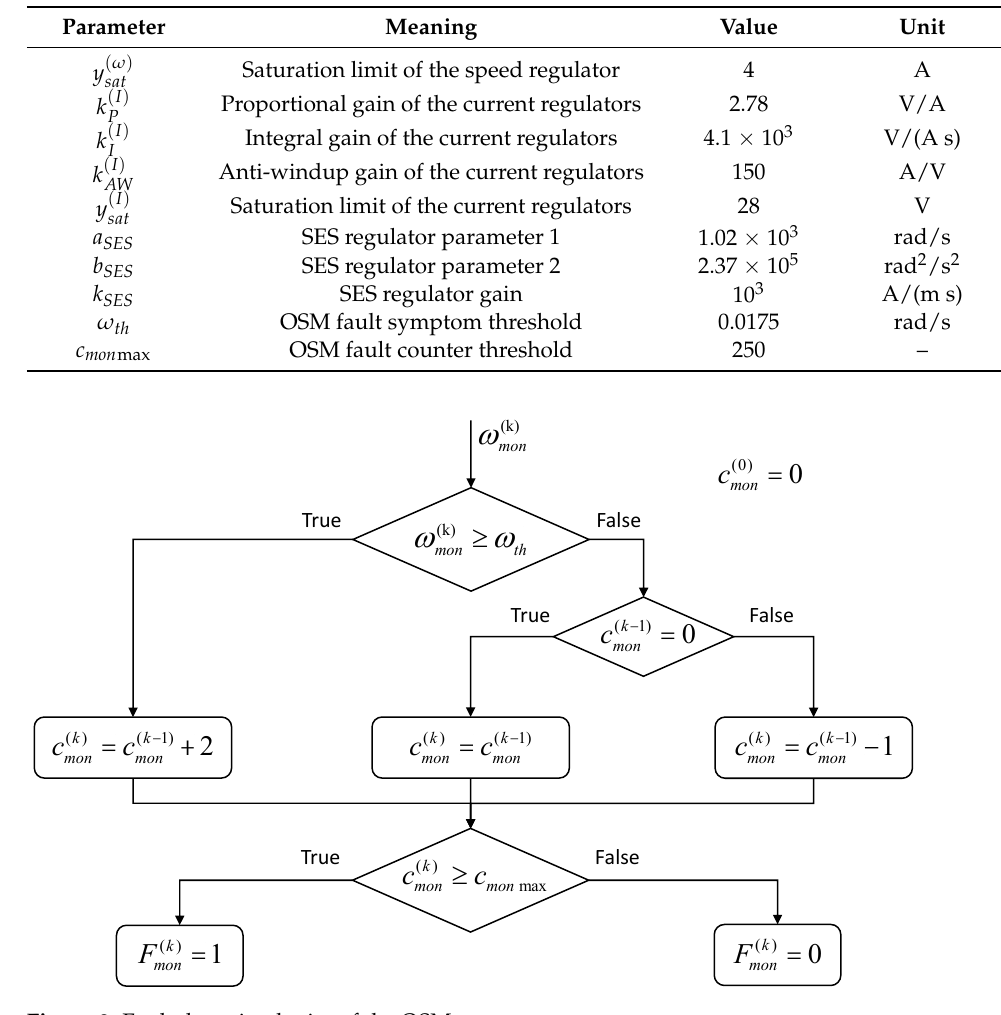
Table 4. Parameters of the electronic section of the model.